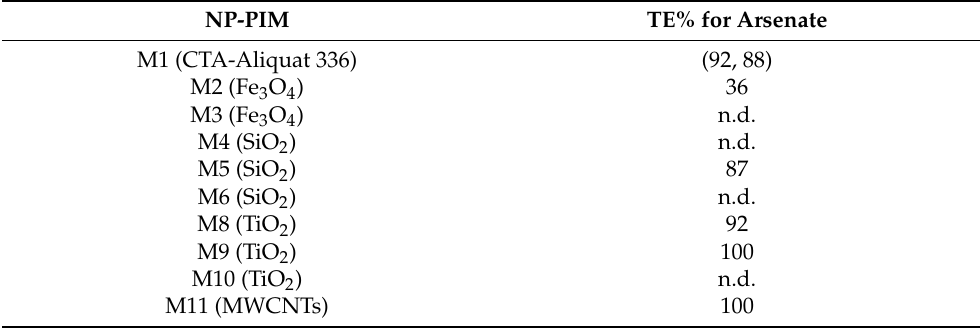
Table 5. Transport efficiency for arsenate (0.1 mg L − 1 As in SNW), after 24 h contact time. Receiving solution 2 M